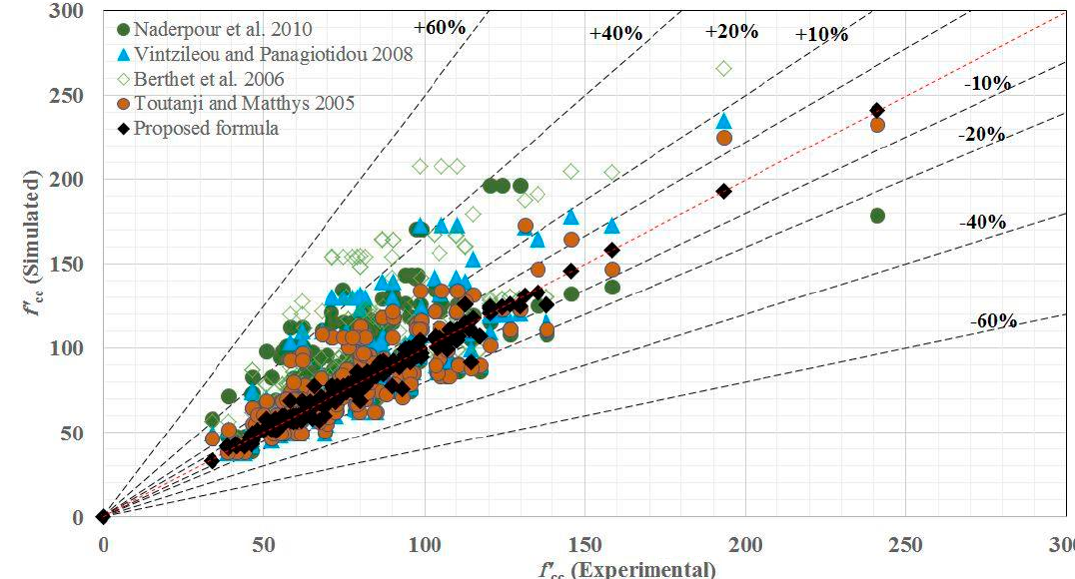
Figure 12. Comparison between simulated and experimental results for the compressive strength of FRPCCC.